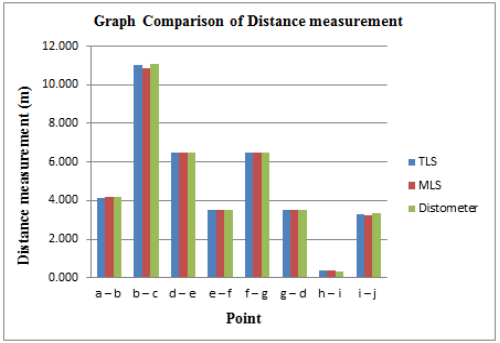
Figure 19. Graph comparison of distance